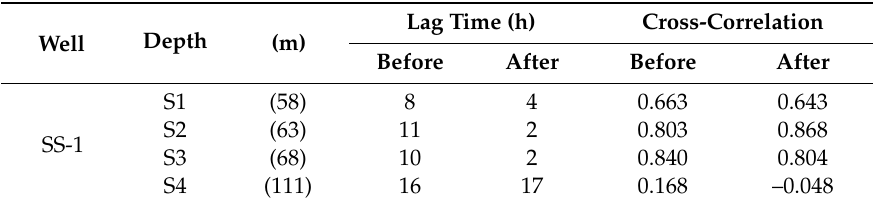
Figure 10. Cross-correlation of EC and ocean tide at S1, S2, S3, and S4 depths in well SS-1 before and after the M 9.0 earthquake. Table 5. Cross-correlation and lag time of EC and ocean tide at S1, S2, S3, and S4 depths in well SS-1 before and after the M 9.0 Tohoku-Oki